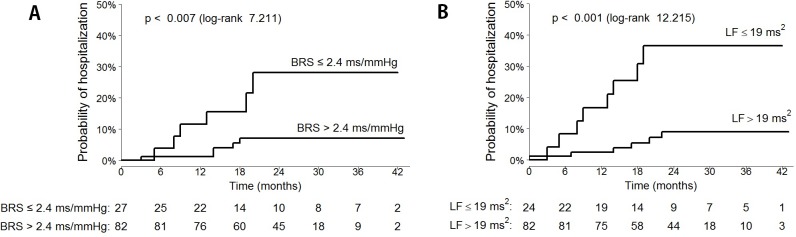
Kaplan-Meier curves illustrating probability of the EVENT depending on pre-specified cut-off values of analyzed autonomic parameters, during follow-up period.Estimated EVENT rates (95% CI) at 12 and 24 months are: (A) 11.5% (0.0–23.0) and 28.1% (5.0–45.6), respectively, for BRS≤2.4 ms/mmHg, and 1.2% (0.0–3.6) and 7.1% (0.9–12.9), respectively, for BRS>2.4 ms/mmHg; (B) 16.7% (0.3–30.3) and 36.5% (12.1–54.2), respectively, for LF≤19 ms2, and 2.4% (0.0–5.7) and 9.0% (1.7–15.8), respectively, for LF>19 ms2.